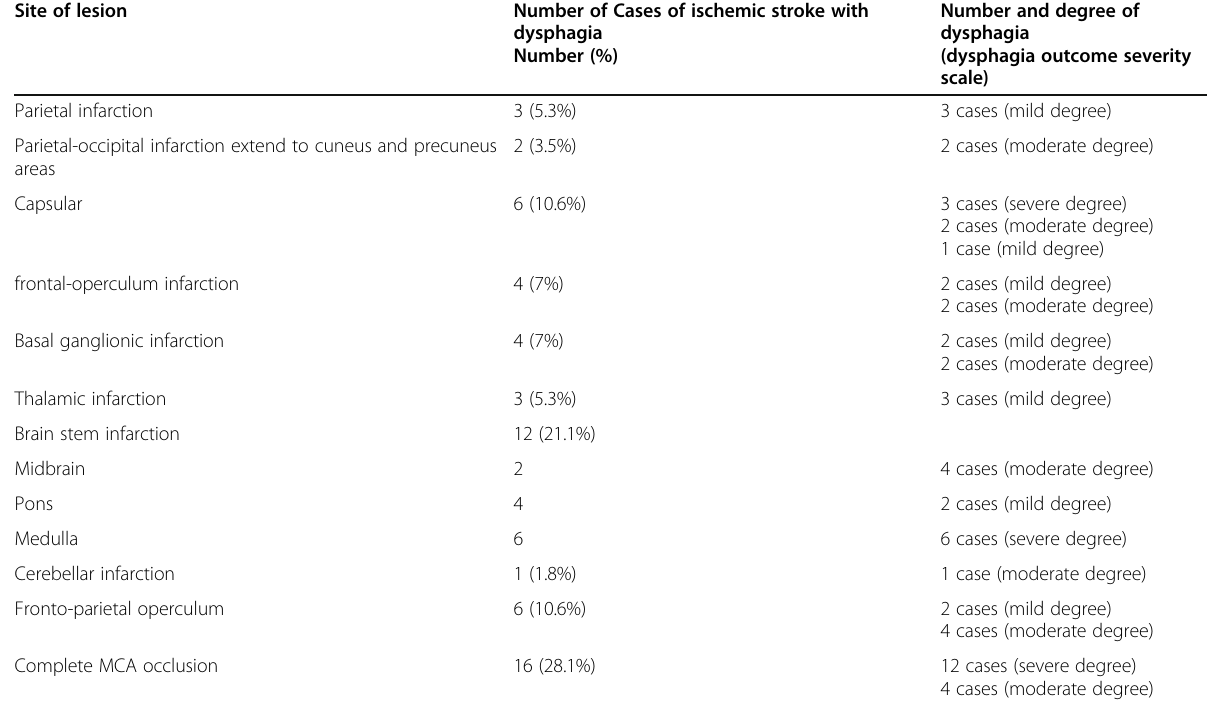
Number and degree of dysphagia (dysphagia outcome severity scale)